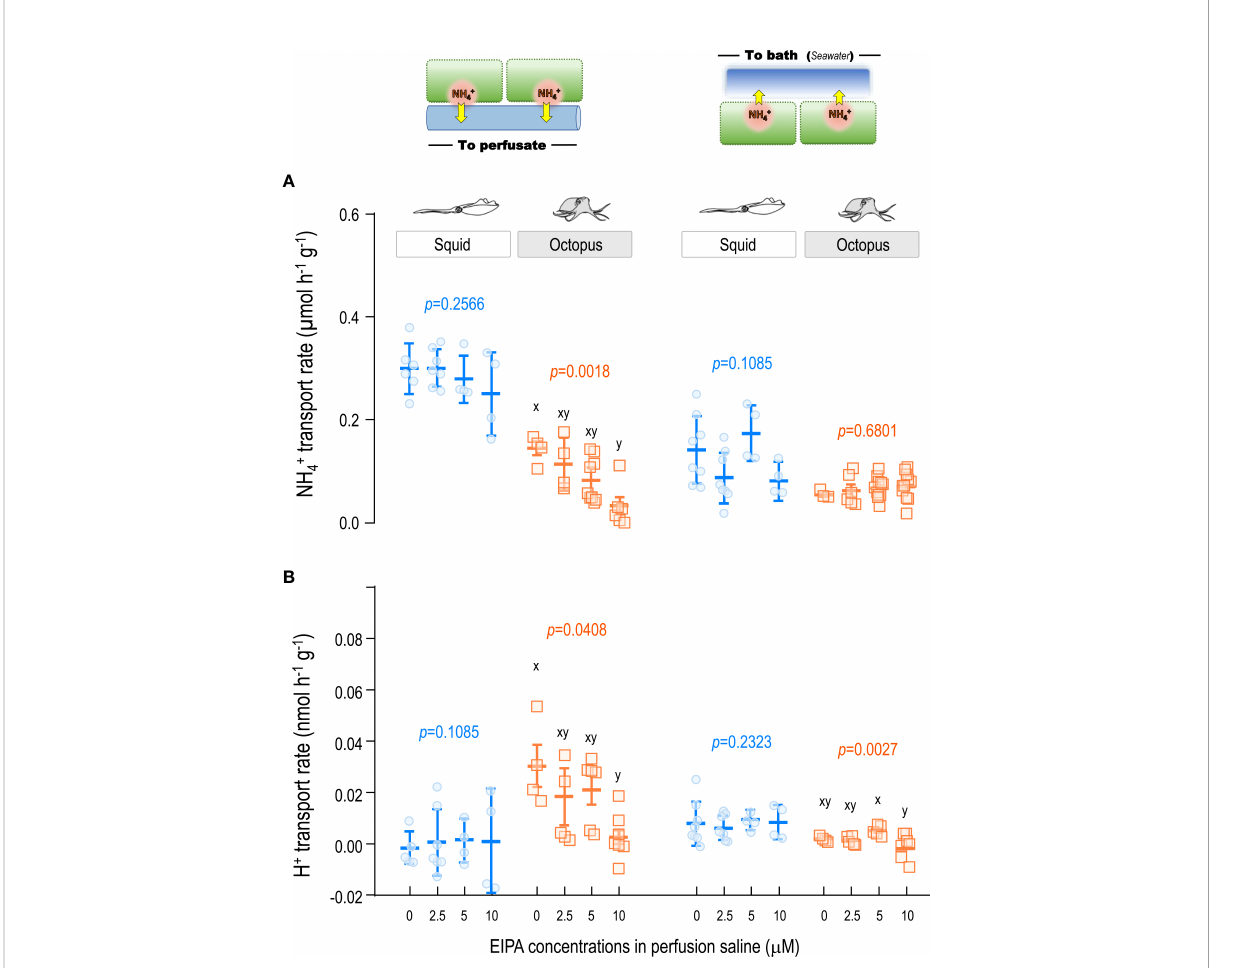
FIGURE 4 Effects of NHE inhibitor EIPA on the NH 4+ and H + transport rates in gill epithelium of squid and octopus by ex-vivo perfusion approach. Different dosages of the NHE inhibitor EIPA were tested for their effects on the NH 4+ (A) and H + (B) transport rates in squid and octopus gills by ex-vivo perfusion. Different letters indicate signi fi cant differences among perfused inhibitor dosages ( p < 0.05; One-way ANOVA, Tukey ’ s pairwise